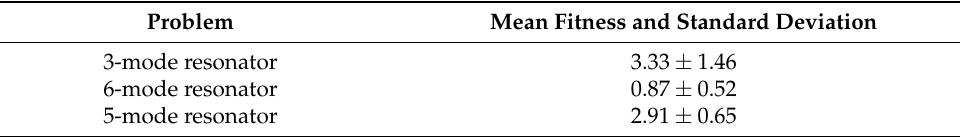
Table 5. Experimental results of the Simulated Annealing algorithm.